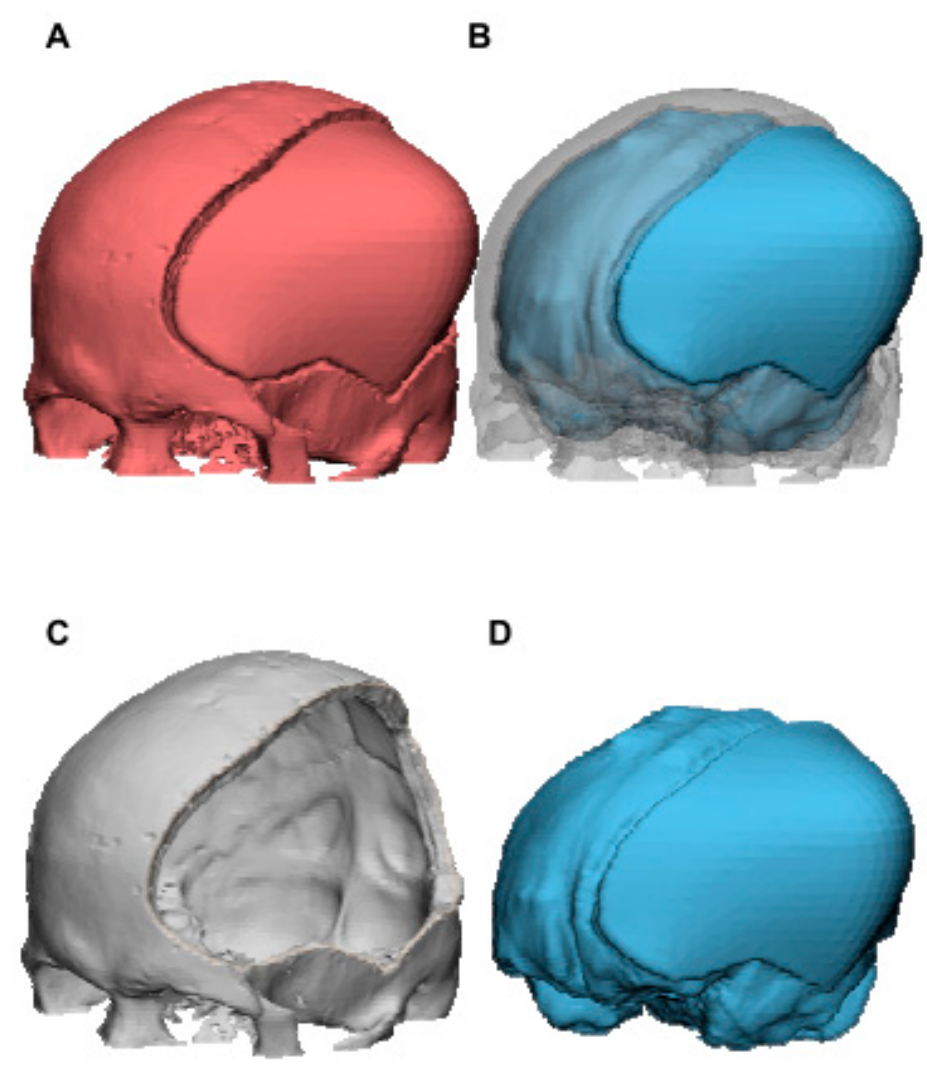
Figure 4. The 3D CAD model for calculation of brain tissue volume of case 3 using Materialise 3-matic. Brain tissue volume ( D ) was obtained by subtracting those of skull bone ( C ) from the whole CAD reconstruction ( A ). Volume of ( B ), which corresponded to ( A ), is equal to the sum of ( C , D ).